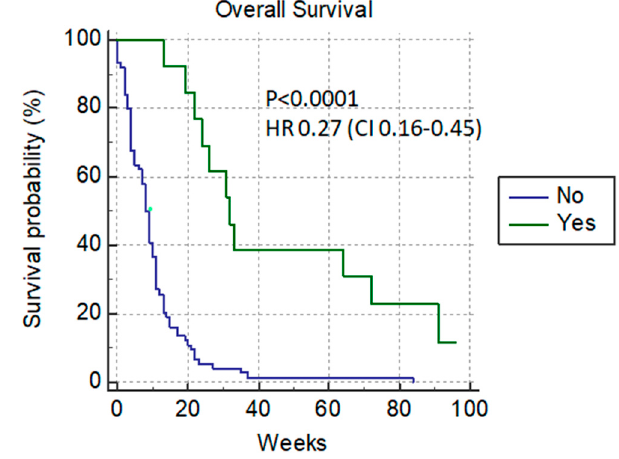
Figure 1. Normalized-bilirubin-level patients after PTBD. Table 1. Patients’ characteristics.